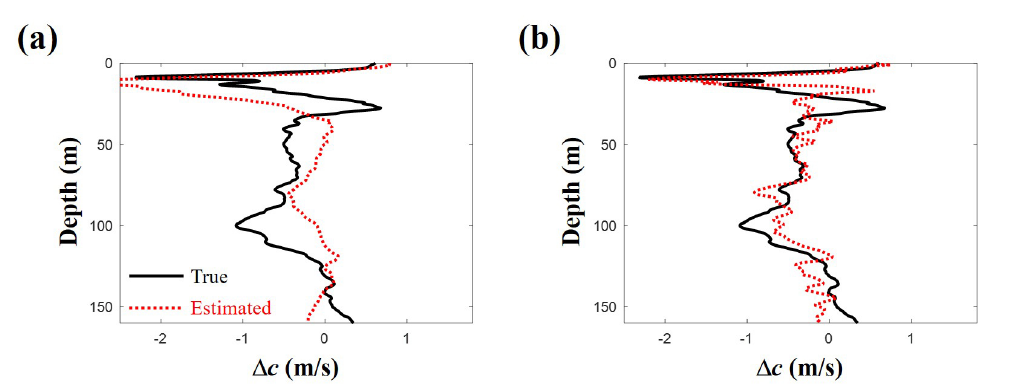
Figure 11. Sound speed differences from the reference sound speed profile estimated from compressive sound speed profile inversion ( a ) without and ( b ) with considering errors in arrival angles. Error angles are uniformly distributed between − 0.05 ◦ and + 0.05 ◦